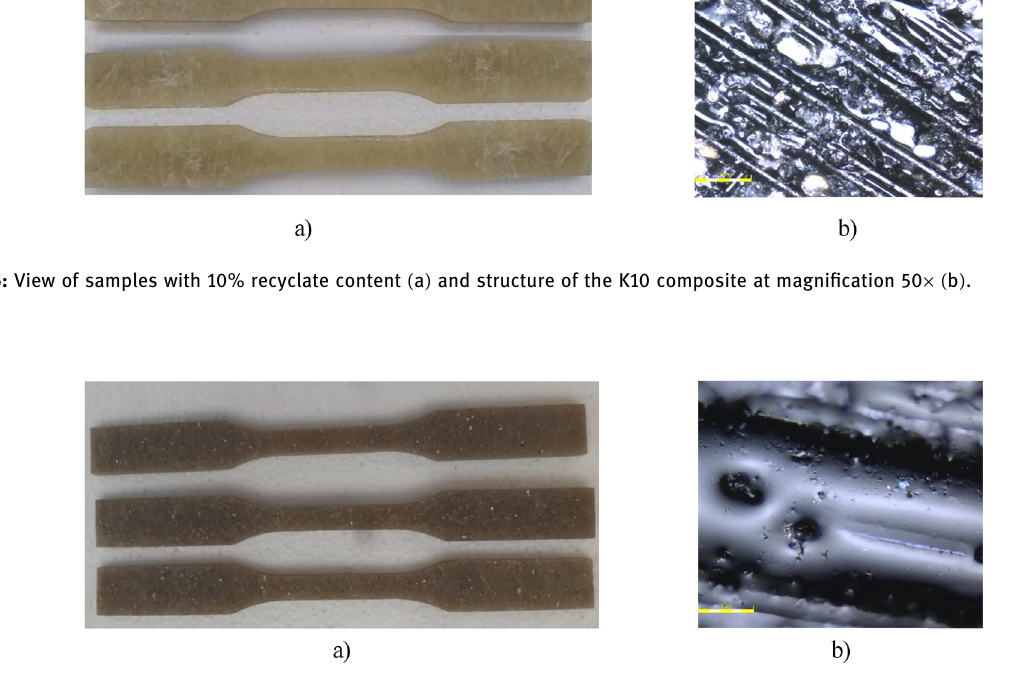
Figure 6: View of samples with 20% recyclate content ( a ) and K20 composite structure at magni fi cation 50 × ( b ) .